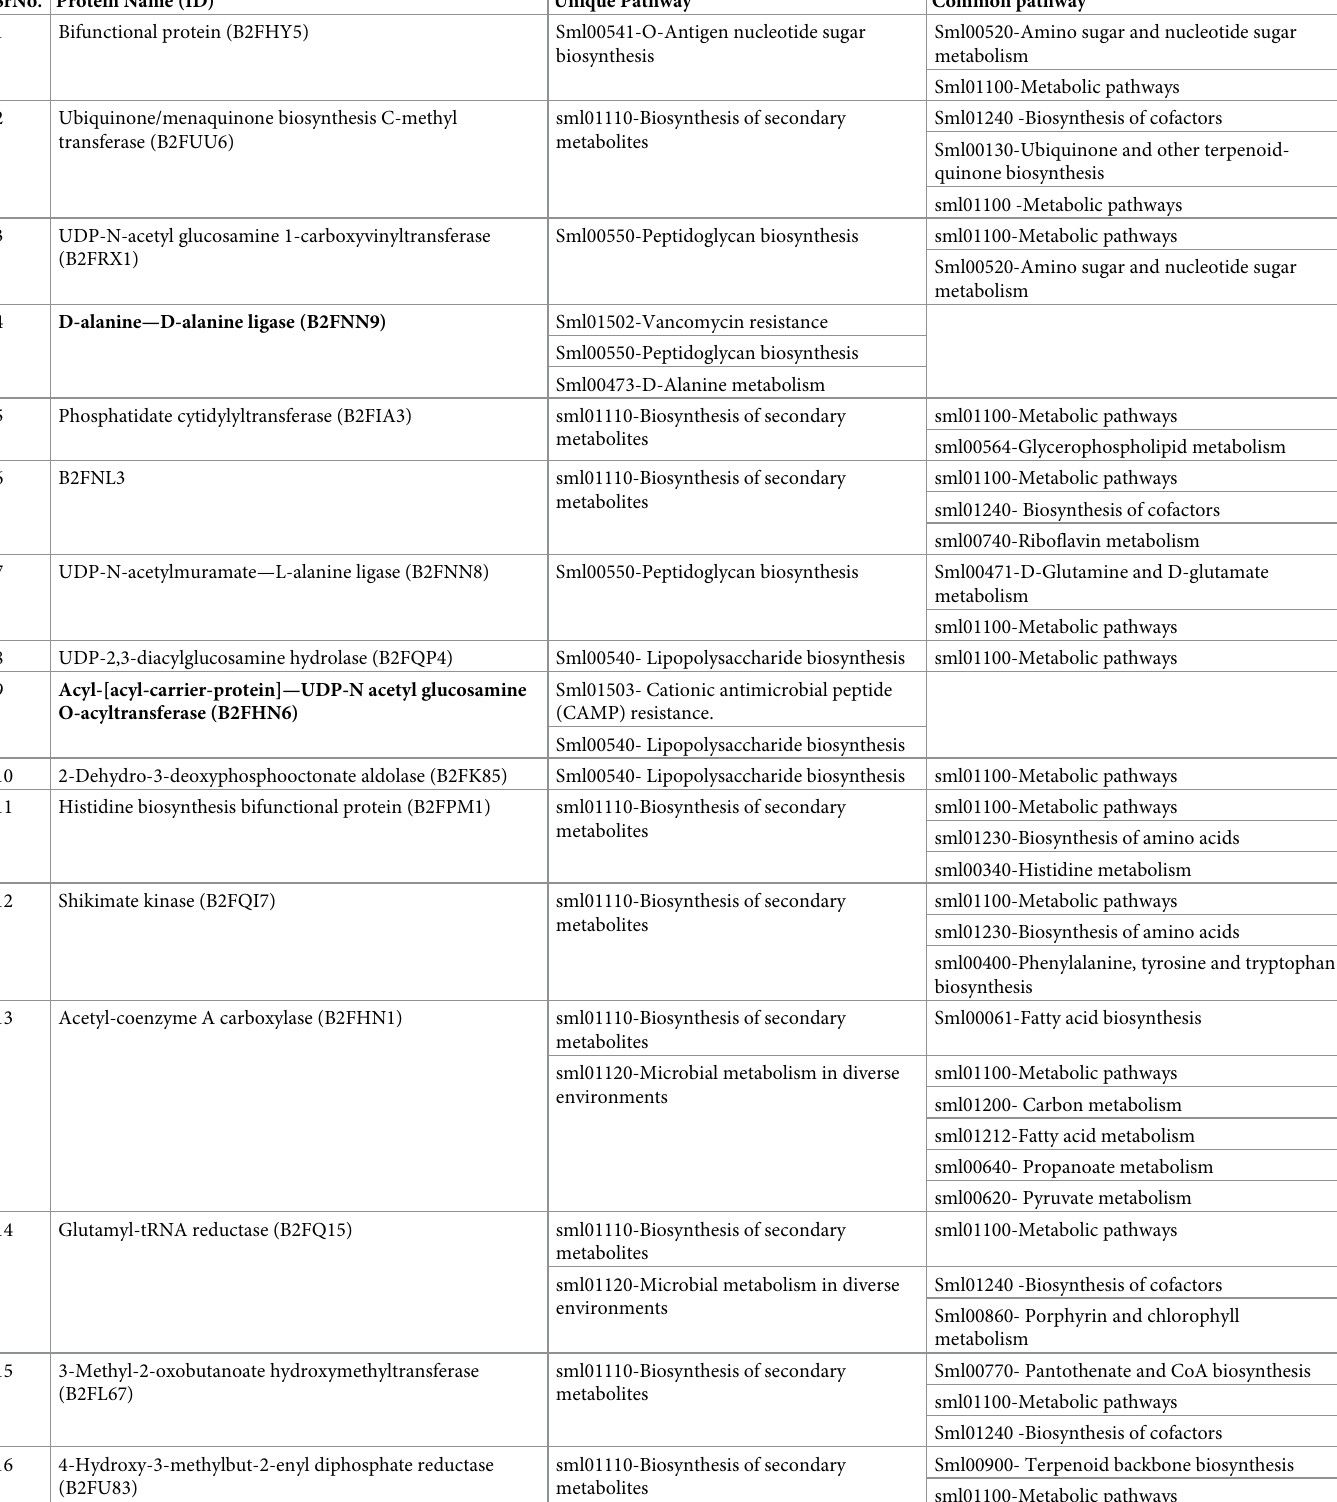
Table 1. Essential non-homologous proteins involved in 27 unique metabolic